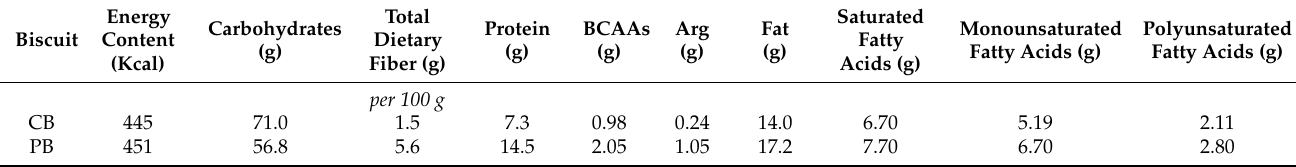
Table 1. Nutritional composition of the two